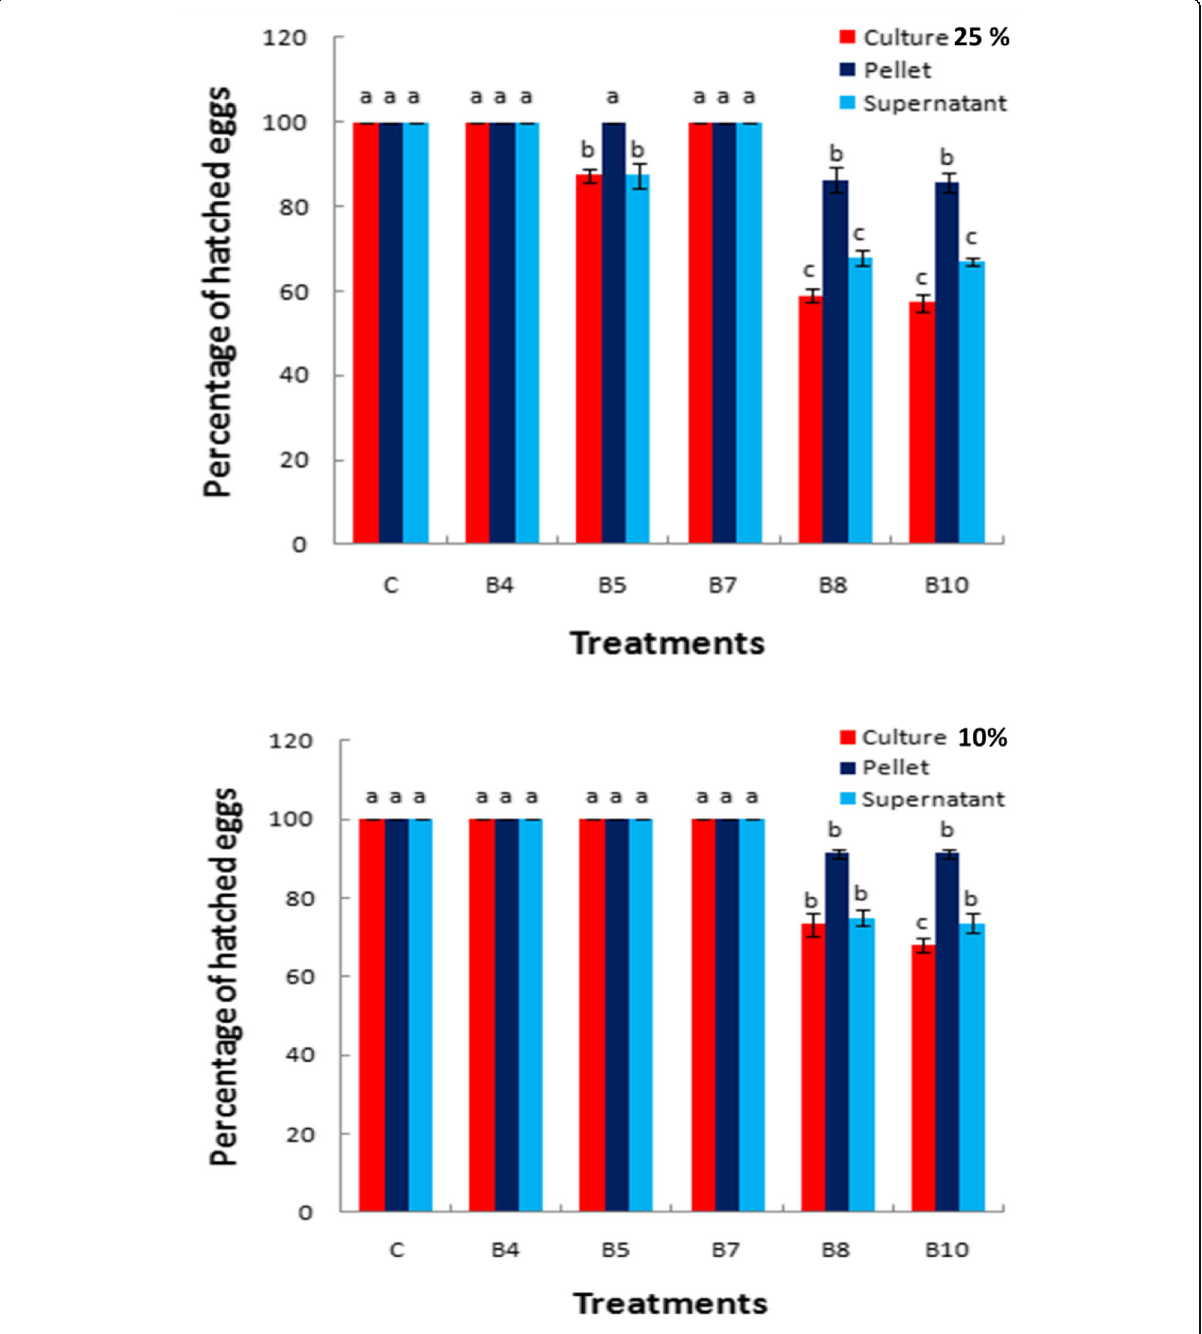
Fig. 2 Effect of culture broth, cell pellet, and supernatant of five Bacillus subtilis isolates (B4, B5, B7, B8, and B10, C is a control) on egg hatching of Meloidogyne incognita at a concentration of 25% and 10%. Values with the identical letters above the bar are not significantly different at P < 0.05